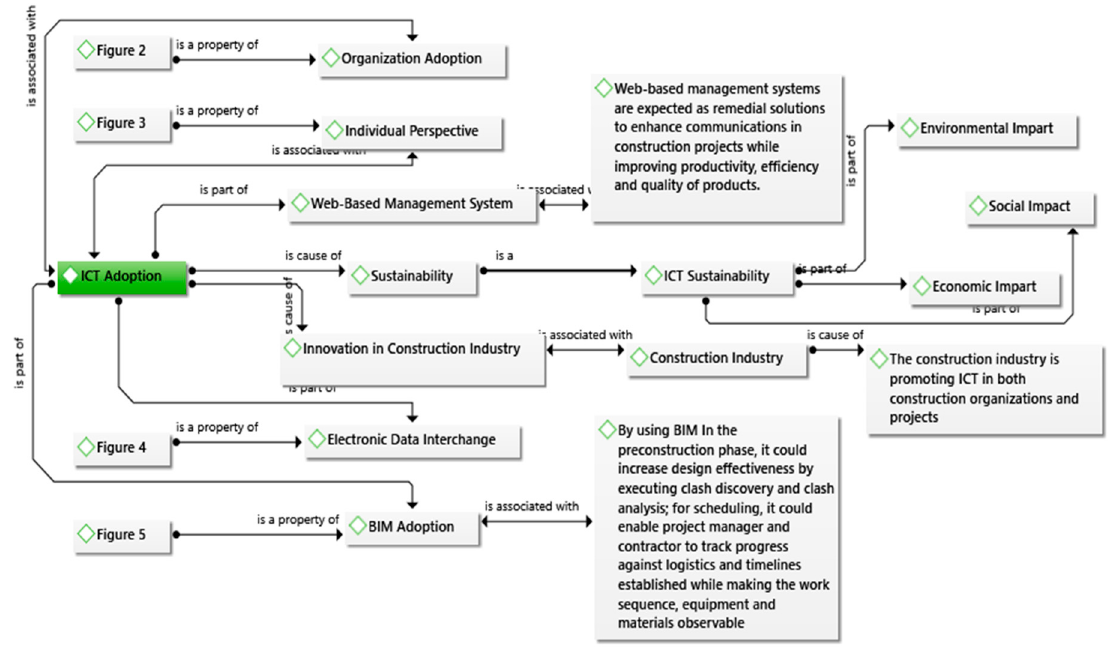
Figure 1. Atlas.ti network view on ICT adoption in the construction industry.